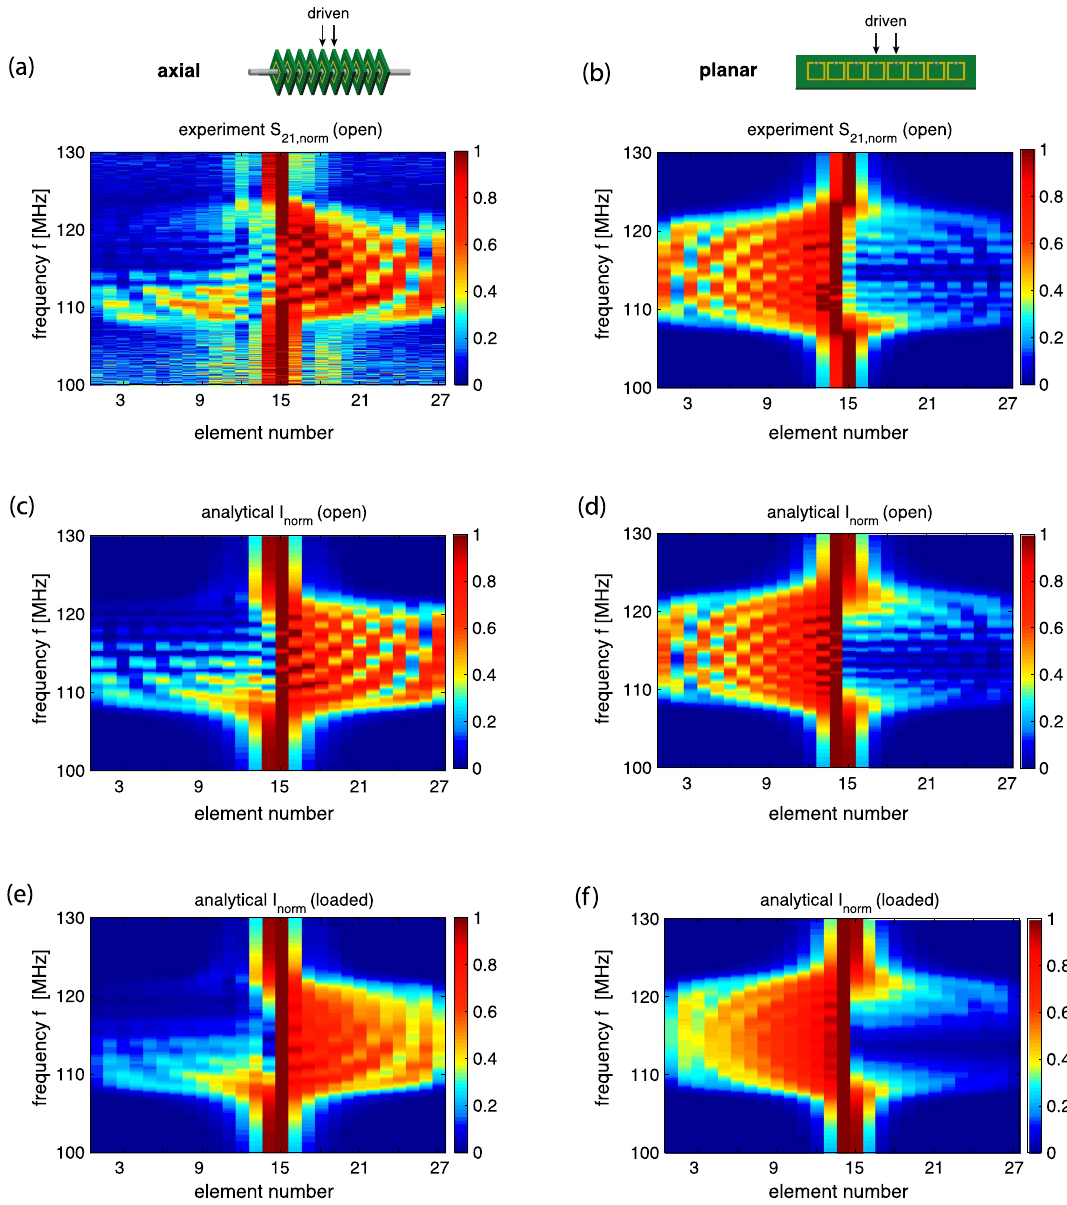
Figure 5. The normalised current distribution in the 27 elements of the MI waveguides over frequency, for an axial array (left column) and for a planar array (right column) shown schematically in the insets, with elements 14 and 15 excited as indicated by arrows. ( a ), ( b ): spectra for the magnitude of S 21 (experiment). ( c )–( f ): spectra for the current magnitude (analytical model). ( a )–( d ): arrays are open (not loaded). ( e ), ( f ): both ends of the array are loaded to suppress